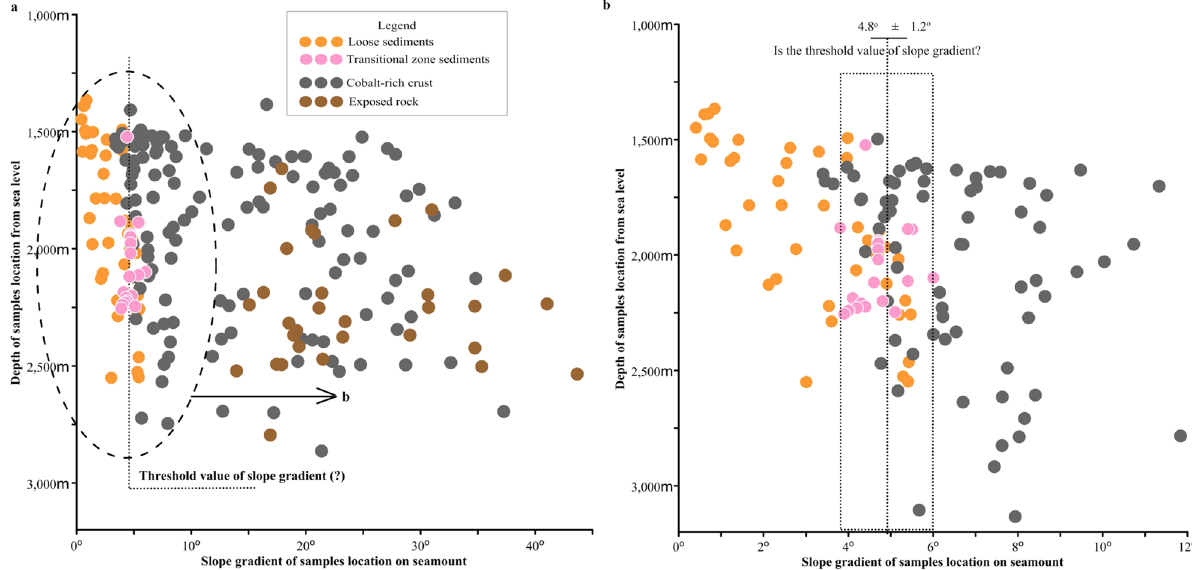
Figure 3. Relationships between slope gradients and types of lithotypes on the seamounts. ( a ) The sample sites are distributed mainly in 3300 m to 1500 m below sea level; the dashed vertical line represents the potential gradient threshold value of 4.8°. ( b ) 4.8° ± 1.2° is the potential threshold value range to control the distribution of loose sediments, transitional zone sediments, and consolidated units (cobalt-rich crust and exposed rock) respectively. Exposed rock samples, their number is 31, are on the slopes, with range of 15.1°–43.7°, and mean of 24.4° gradients; Cobalt-rich crust samples, their number is 132, are on the slopes, with range of 3.4°–37.3°, and mean of 13.9° gradients; Transitional zone depositions, their number is 20, are on the slopes, with range of 3.6°–6.0°, and mean of 4.0° gradients; Loose sediments, their number is 42, are on the slopes, with range of 0.4°–5.5°, and mean of 3.1° gradients.